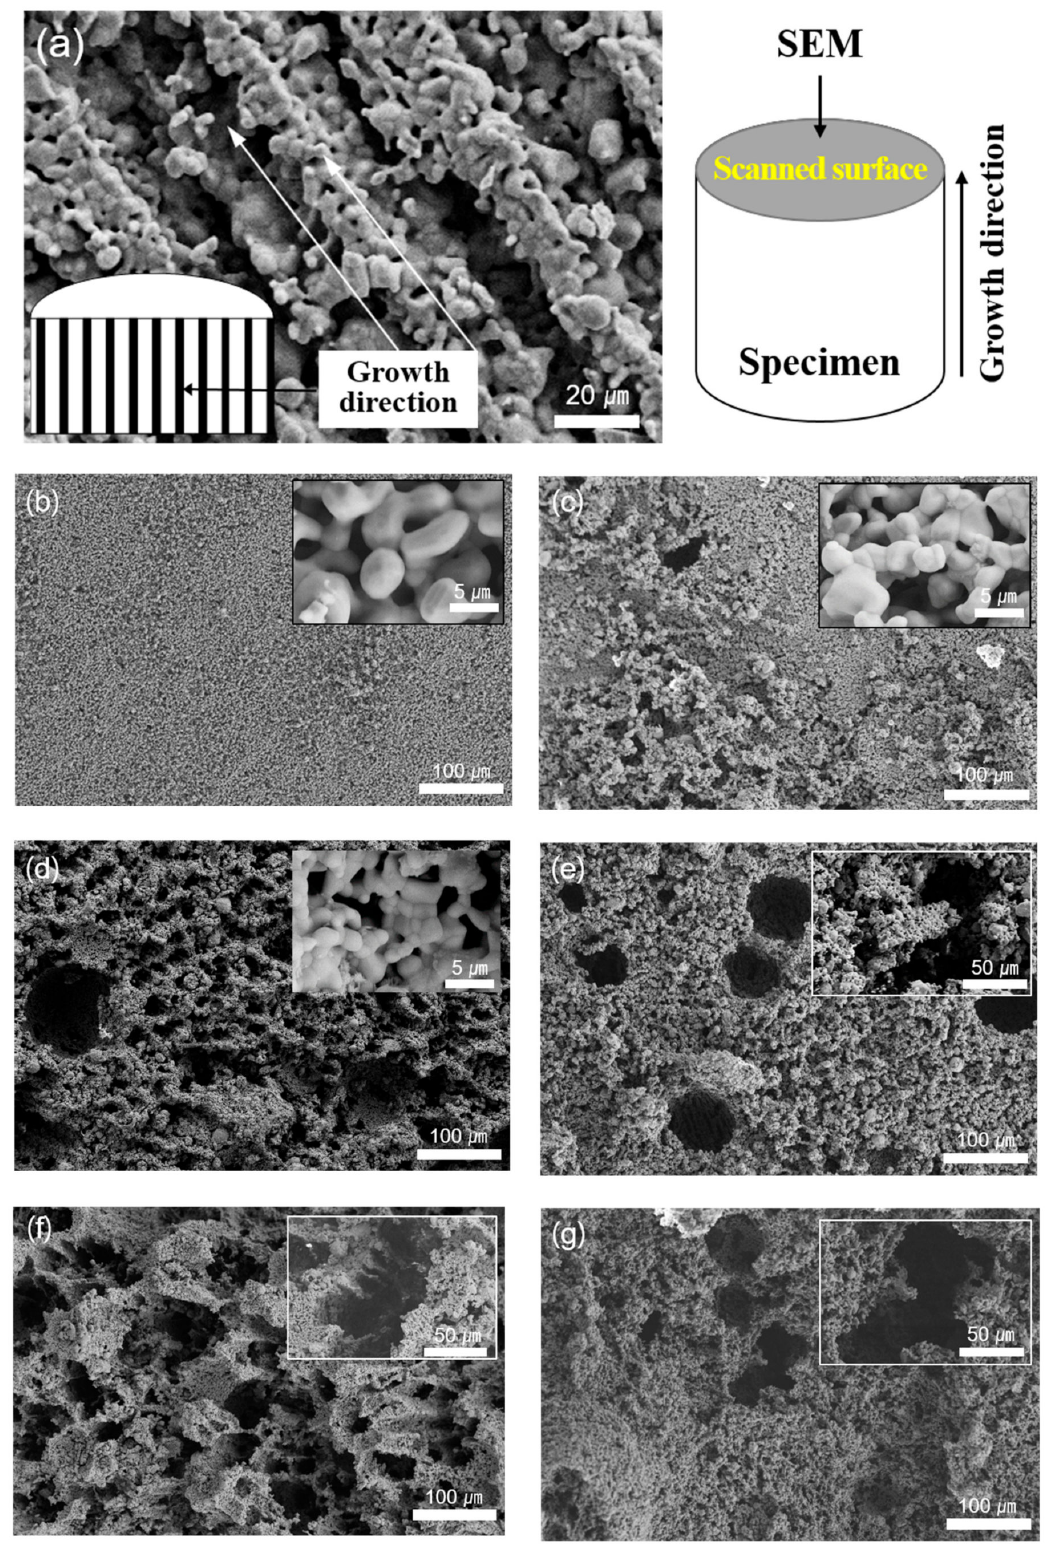
Figure 7. ( a ) SEM images of cross-section parallel to the macroscopic tert-butyl alcohol (TBA) freezing growth direction of HA0; and the images of surface perpendicular to the macroscopic TBA freezing growth direction: ( b ) HA0, ( c ) HA15, ( d ) HA30, ( e ) HA45, ( f ) HA60, and ( g )